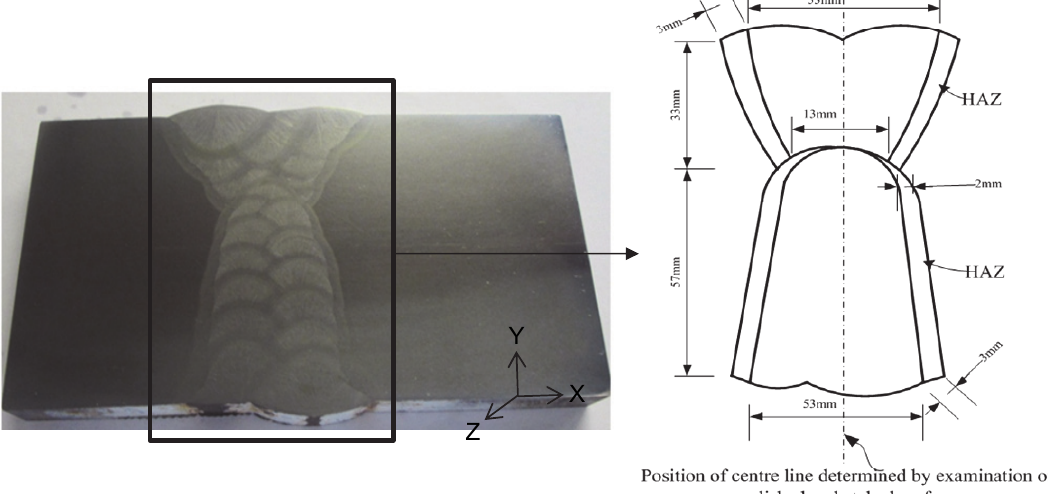
Figure 1: 90mm 355D steel weldment typical of an offshore wind monopile